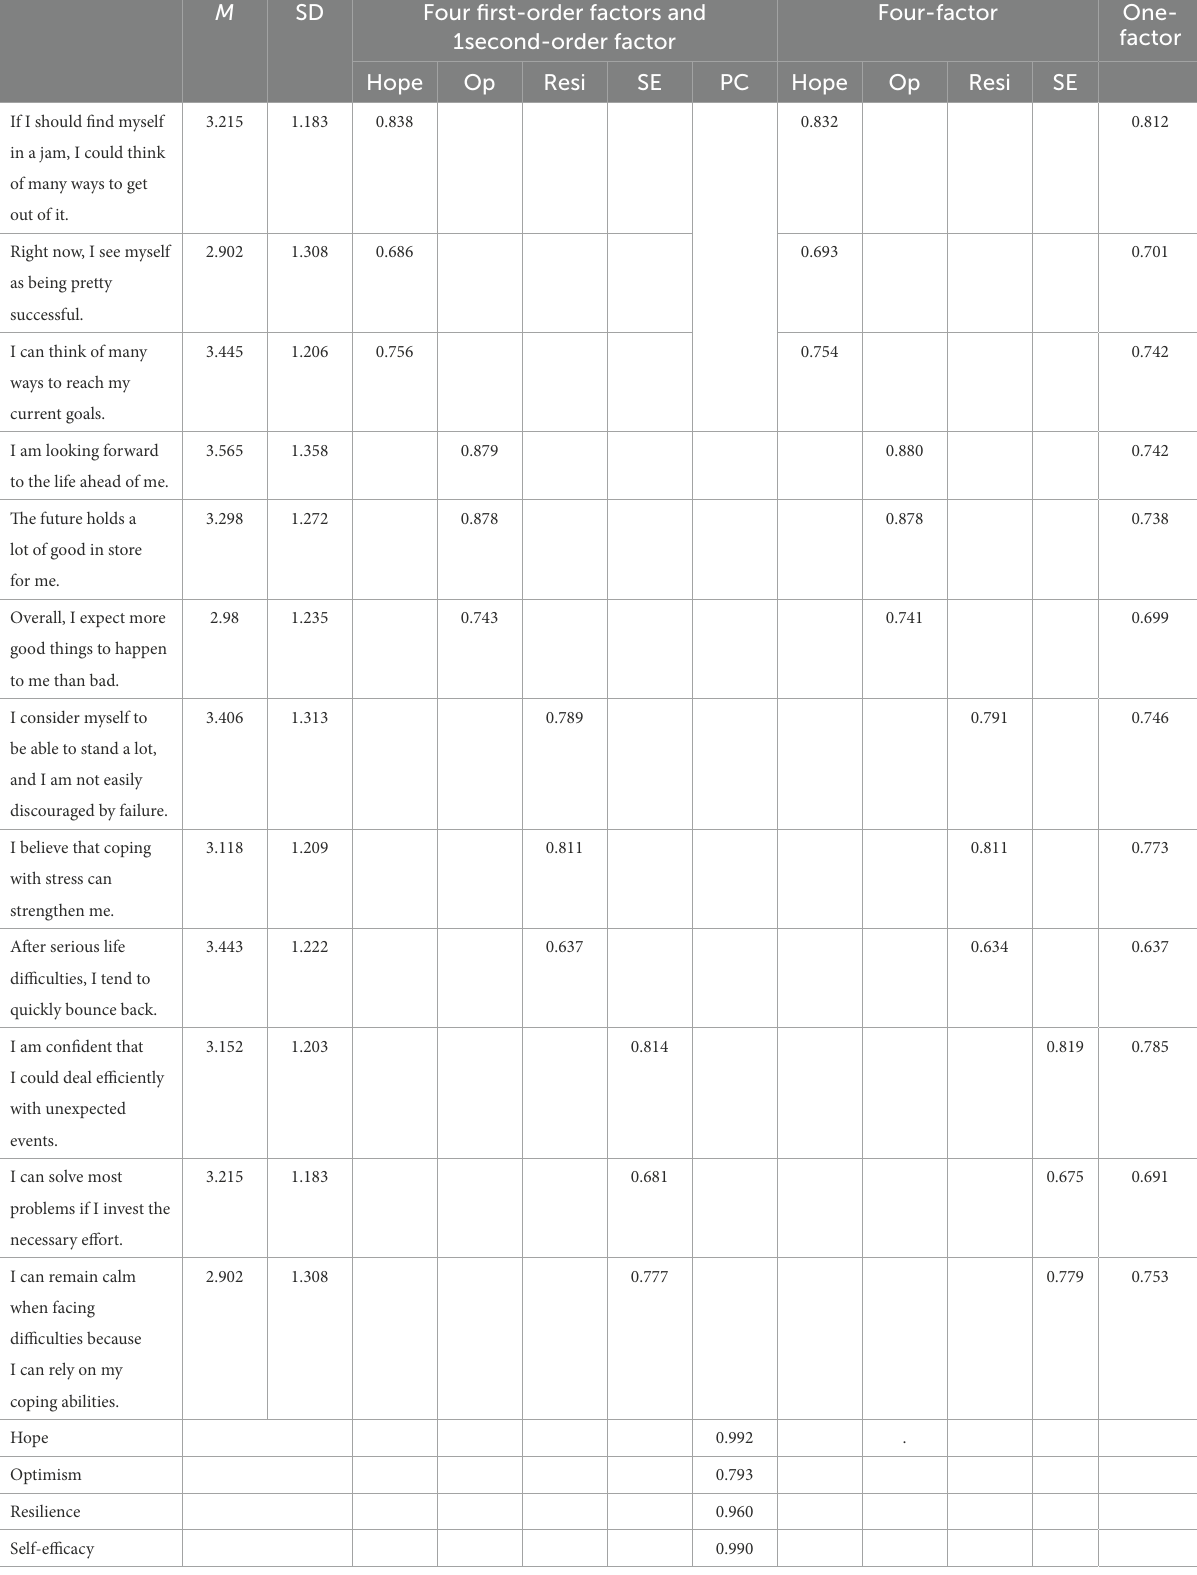
TABLE 2 Factor loadings obtained by confirmatory factor analysis. M SD Four first-order factors and Four-factor One- factor1 second-order factor Hope Op Resi SE PC Hope Op Resi